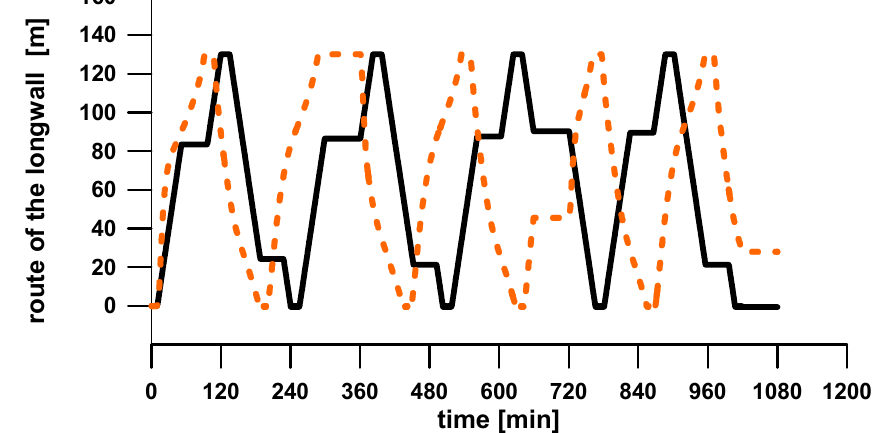
Figure 4. Route of the shearer in longwall 841A, where the intermittent orange line represents the controlled speed and the black line indicates the case without speed control.